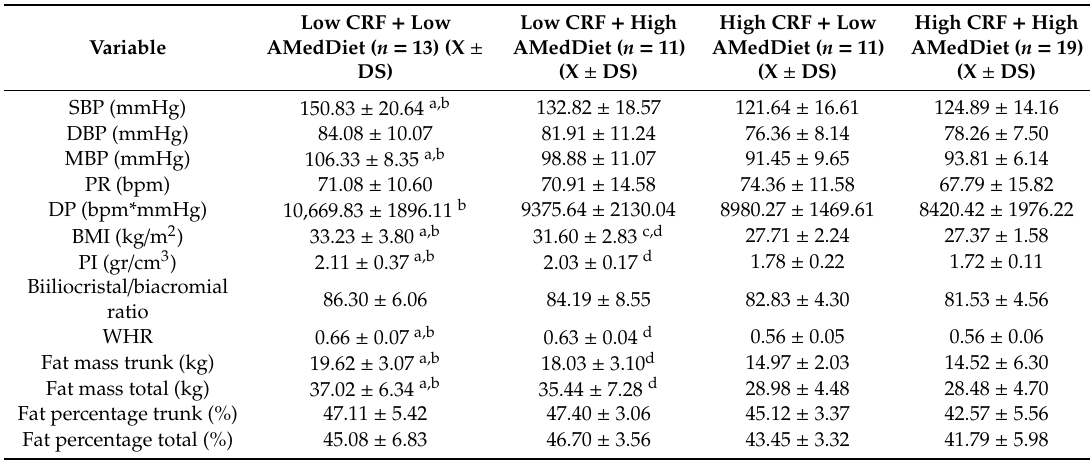
Table 5. Cardiovascular, proportionality, and body composition variables according to adherence to the Mediterranean diet (AMedDiet) and cardiorespiratory fitness